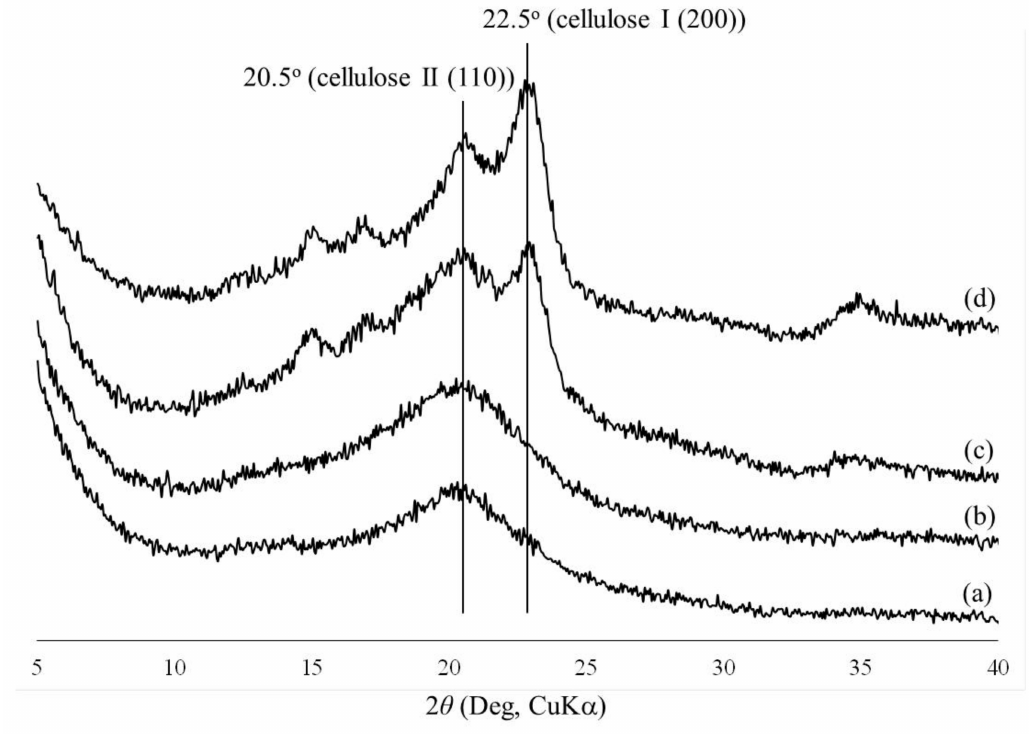
Figure 5. XRD profiles of regenerated celluloses from cellulose / BMIMCl solutions ( a – d , 5, 10, 12, and 15 wt.%) using